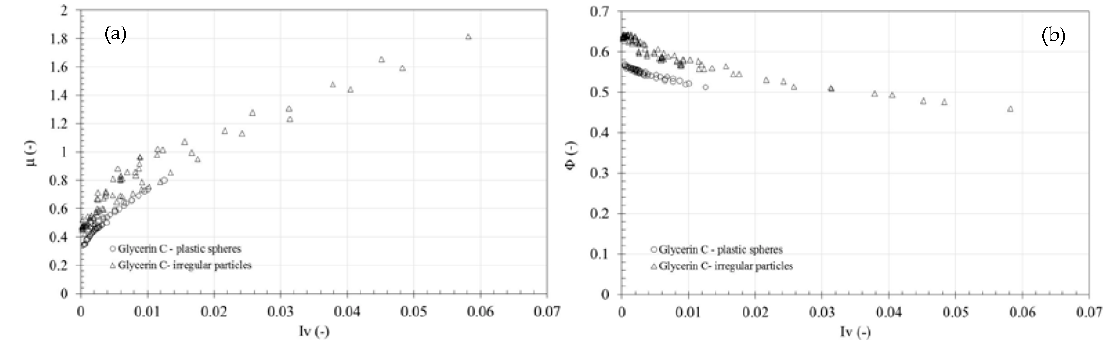
Figure 8. Plastic spheres and plastic irregular grains (simple shearing configuration). ( a ) correlation between the friction coefficient µ and the viscous number I v . ( b ) correlation between the volume fraction Ф and the viscous number I v .